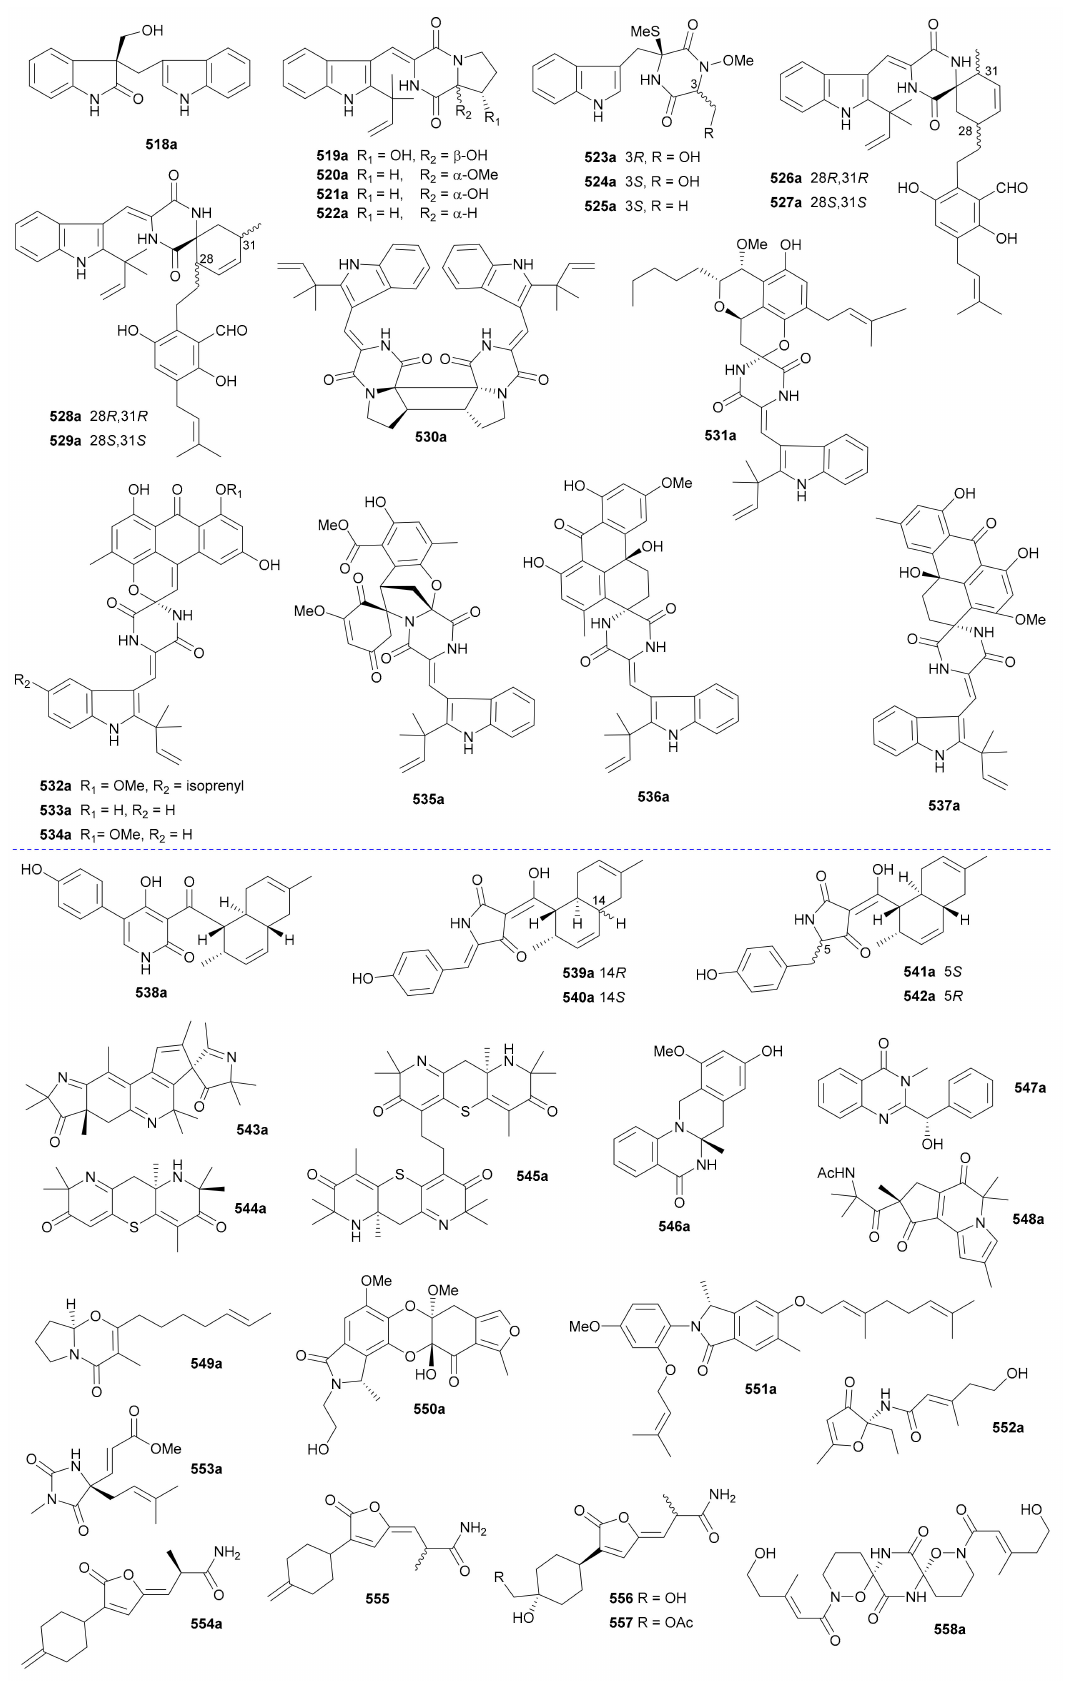
Figure 30. Structures of alkaloids from phylum